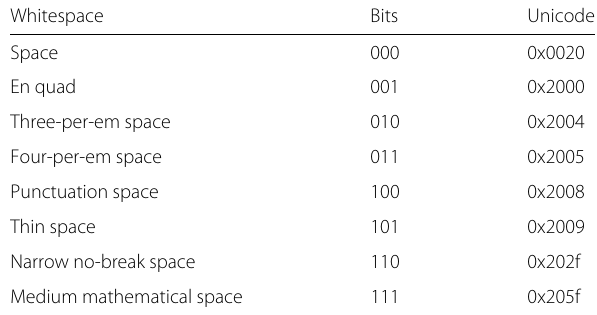
Table 2 Encoding bits for whitespace symbols